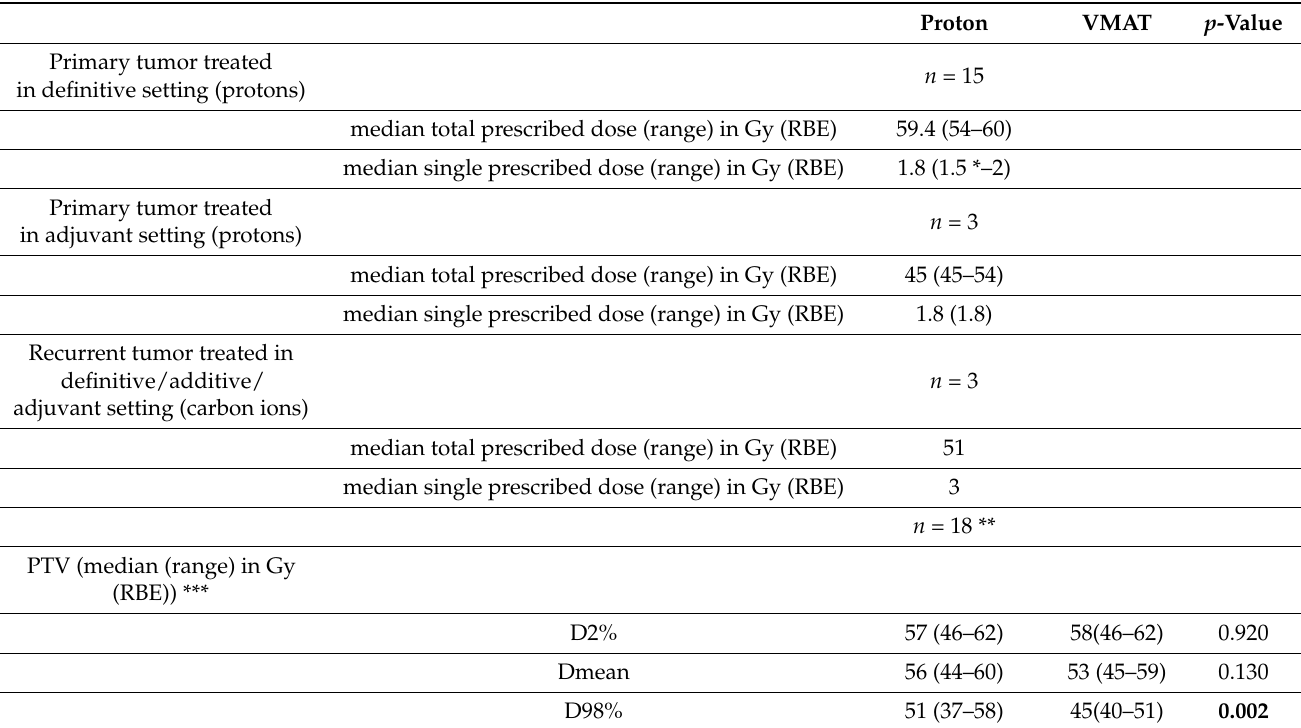
Table 3. Prescribed doses and DVH